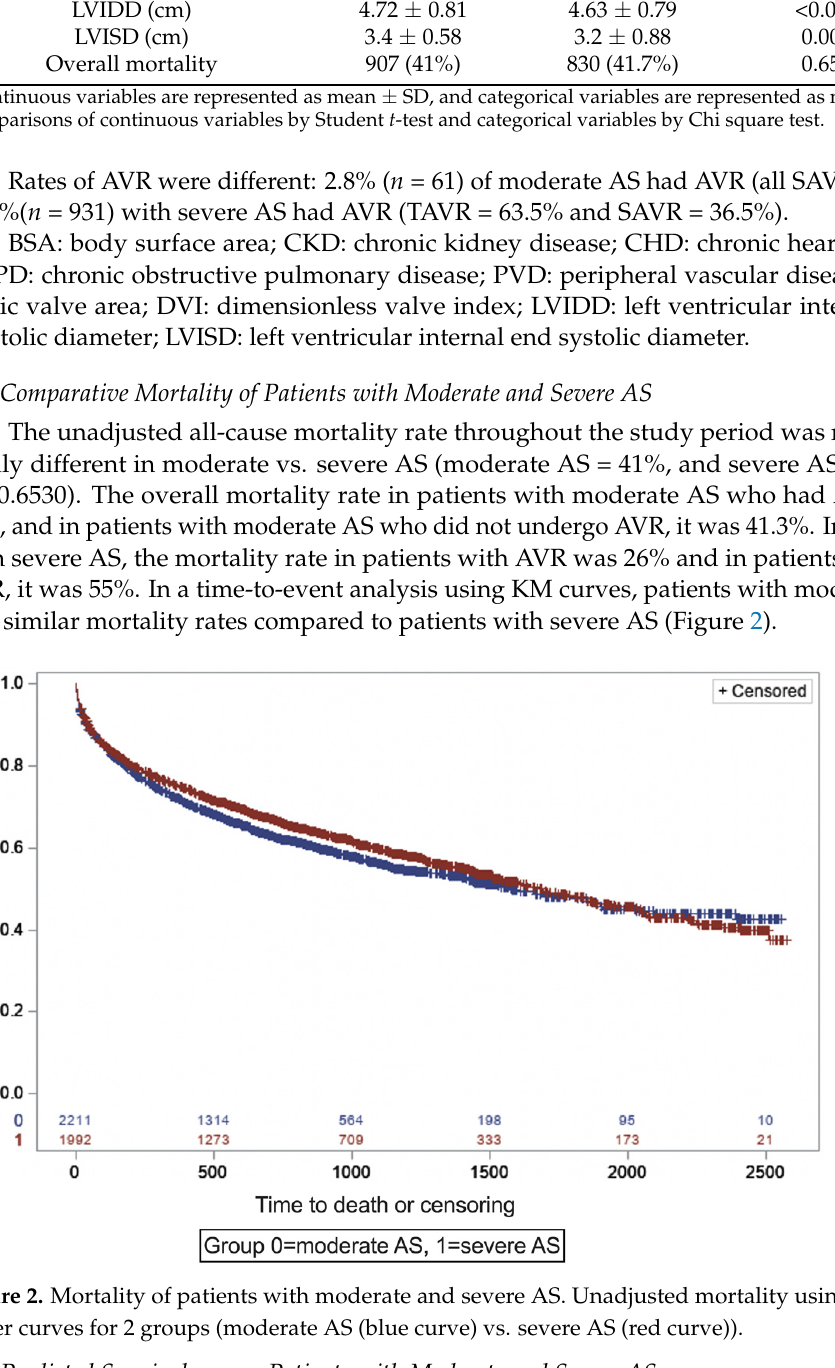
Table 2. Cox proportional regression coefficients and hazard ratios for AS patients with 1-year and 5-year follow-up. Patients with 1-Year Follow-up